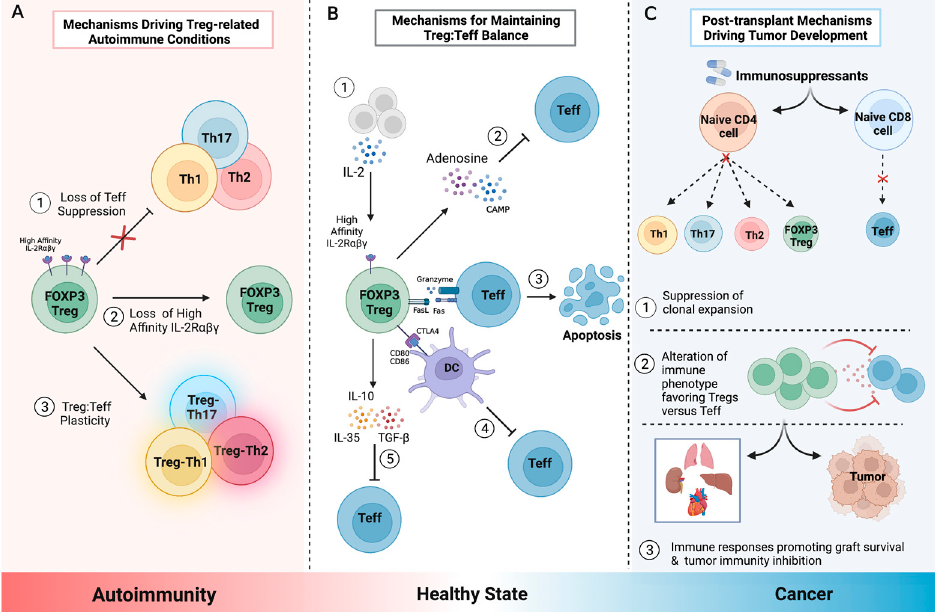
Figure 1. Tregs homeostasis and dysregulation. Tregs interact with effector T cells (Teffs) to modulate the immune responses and maintain self-tolerance. Tregs act by suppressing Teffs through various mechanisms that, when disrupted, can lead to several autoimmune conditions and